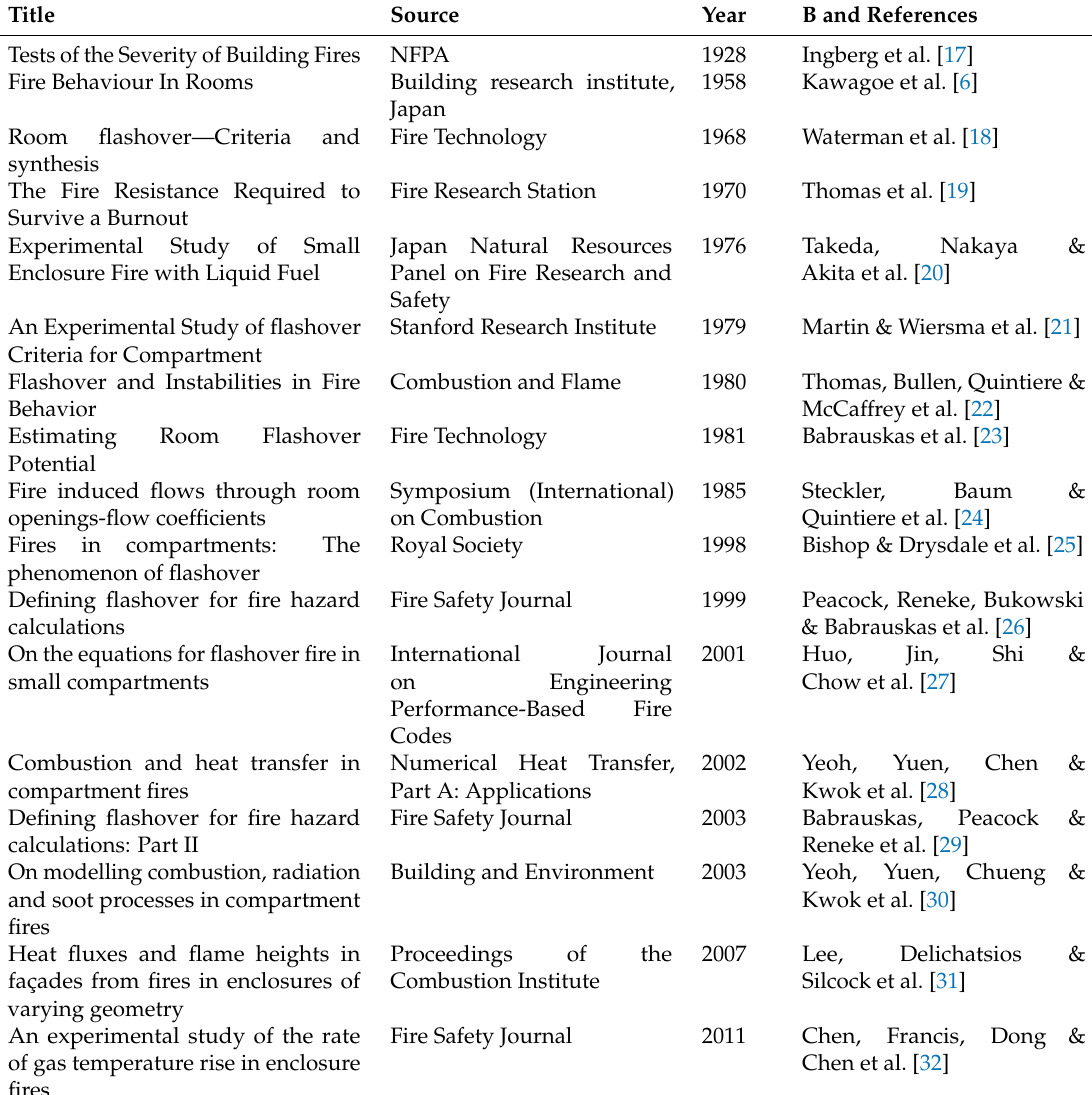
Table 4. Relevant work about fire dynamics in